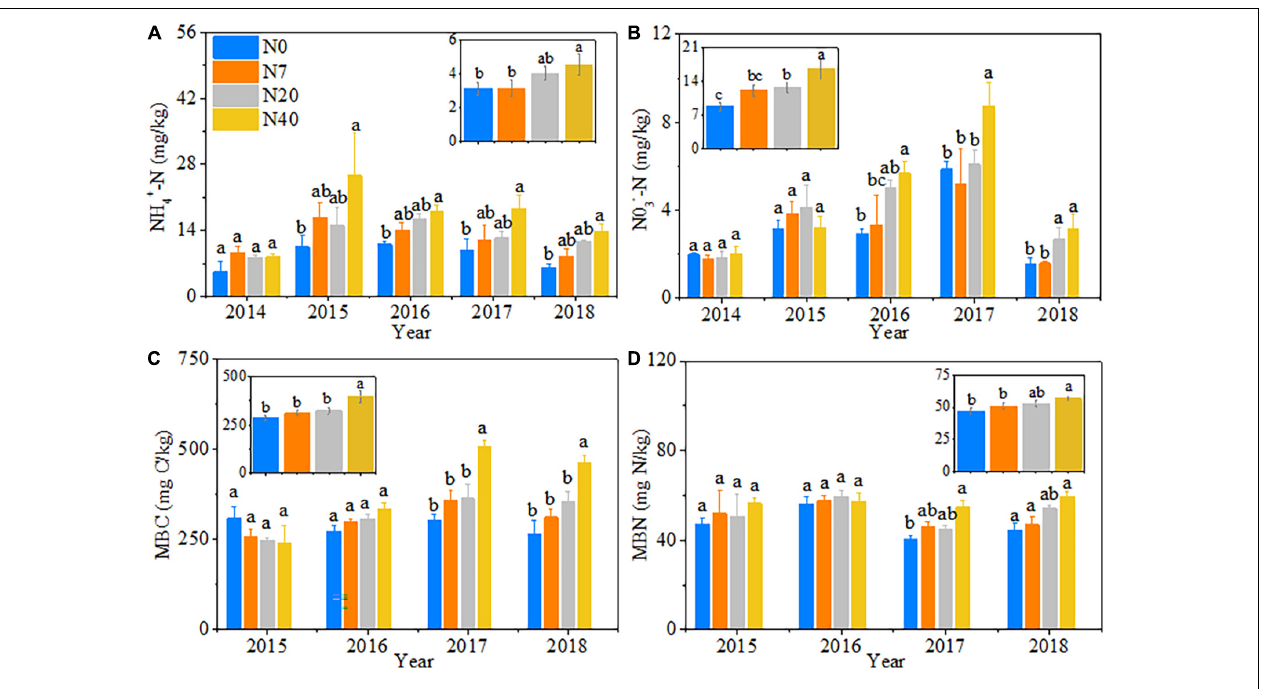
FIGURE 1 | Patterns in soil properties with increasing N addition from 2014 to 2018. N0–N40: expressed as control, 0, 7, 20, and 40 kg N ha − 1 year − 1 . (A) NH 4 + –N, soil ammonium nitrogen; (B) NO 3 − –N, soil nitrate–nitrogen; (C) MBC, soil microbial biomass carbon; (D) MBN, soil microbial biomass nitrogen. The error bars represent the standard error (SE). Different lowercase letters indicate significant differences ( p < 0.05) among different N-addition levels